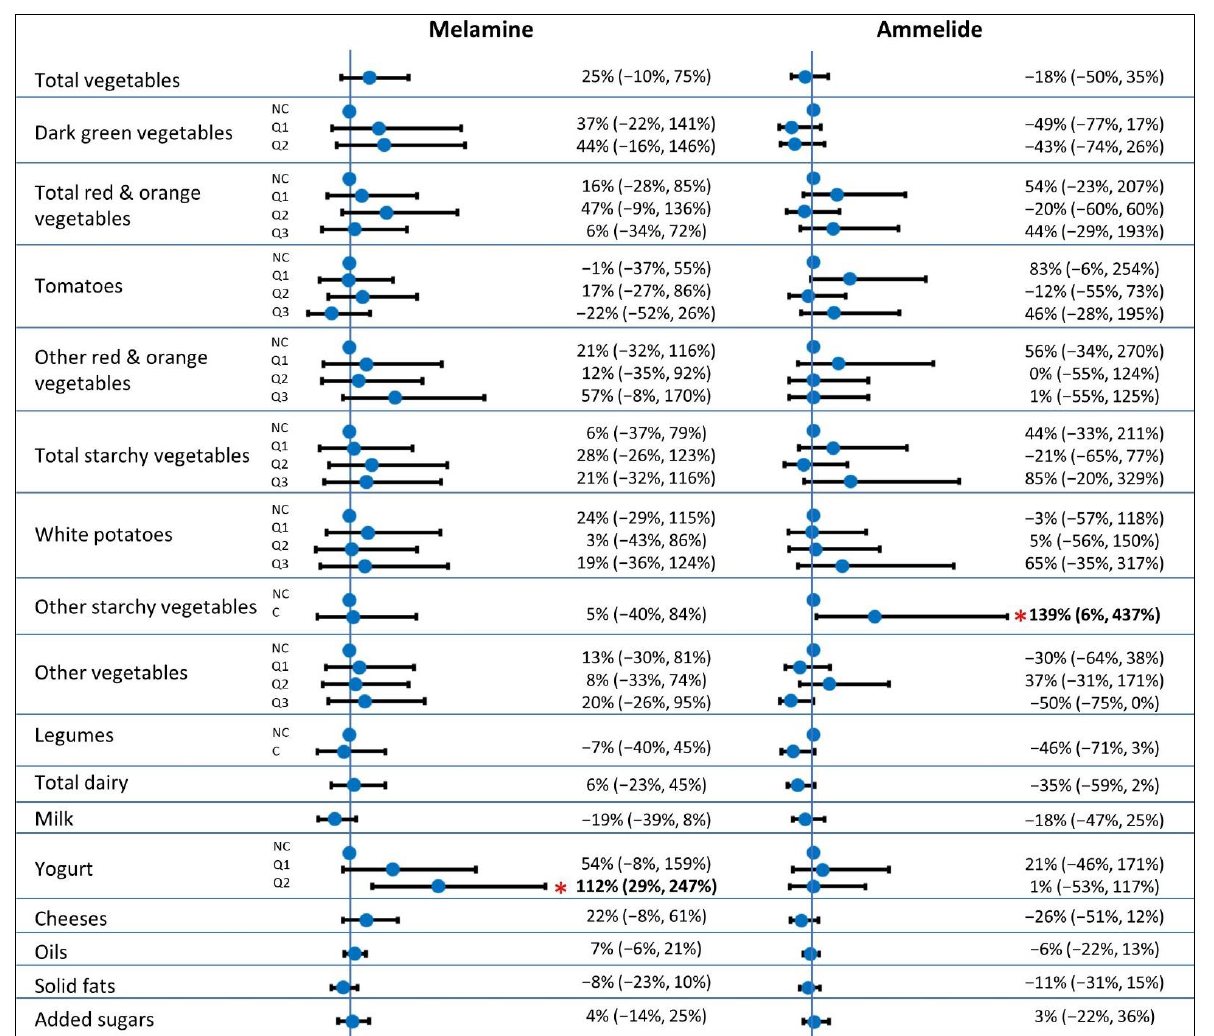
Figure 2. Estimated percentage difference (with 95% CI) in urinary melamine or ammelide concen- trations for a 50% increase in consumption (continuous dietary variables) or in comparison to the reference group (categorical dietary variables) for vegetables, dairy, fats, and sugars. Estimates with p -values < 0.05 shown in bold text with asterisk. Models adjusted for age, sex, child race and ethnicity (Non-Hispanic White, Hispanic White, multiple races, other), household income (<45 k, 45–75 k, 75–100 k, 100–150 k, >150 k), maternal education (<college grad, college grad, advanced degree), BMI for age percentile (continuous), pesticide use in home over the last year (yes, no), and site (Seattle, Yakima); Abbreviations: NC, non-consumer; C, consumer; Q1–Q3, quantiles